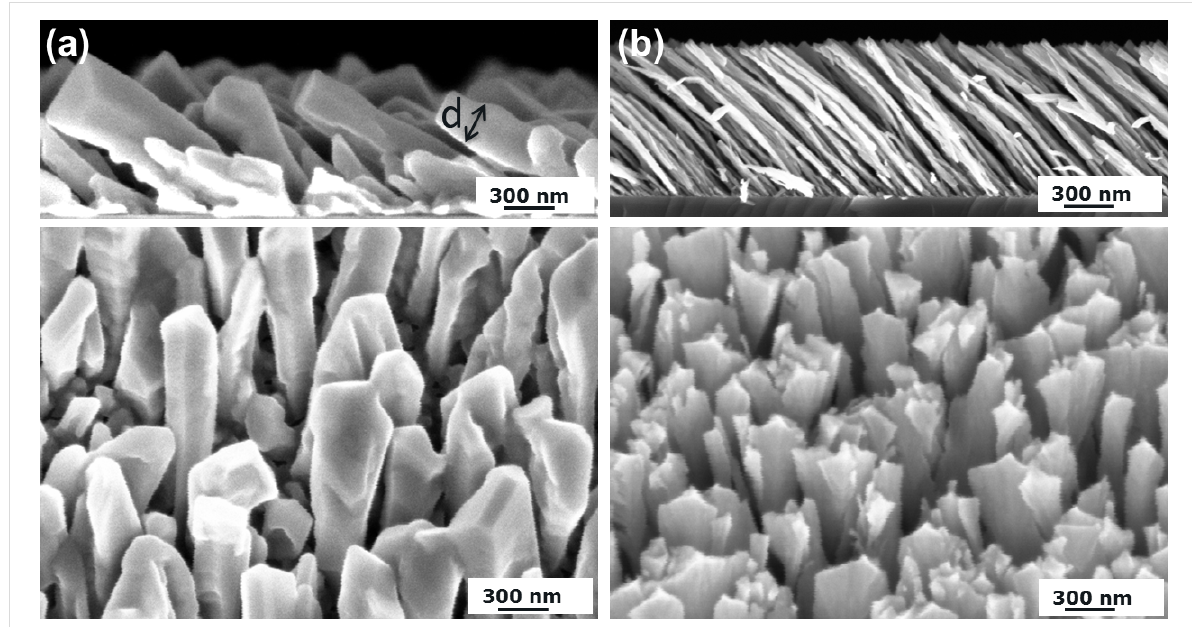
Figure 1: Cross-sectional (top) and top-view (bottom) SEM images of tilted Al columns deposited at an incidence angle of 82° on thermally oxidized Si substrates and at a substrate temperature of (a) 300 K and (b) 77